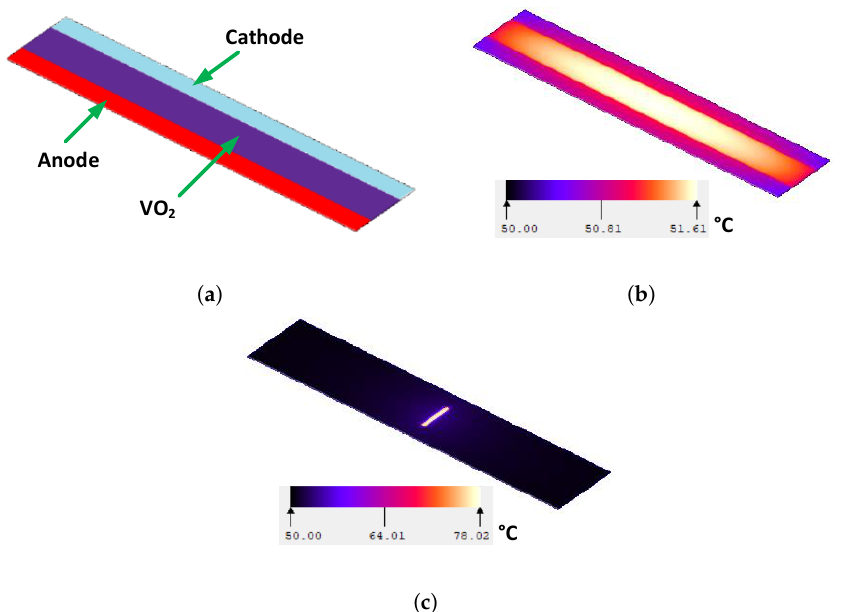
Figure 4. A 200µm × 20µm × 0.5µm VO 2 resistor: ( a ) Structure; ( b ) Temperature distribution at low current (2mA); ( c ) Temperature distribution at high current